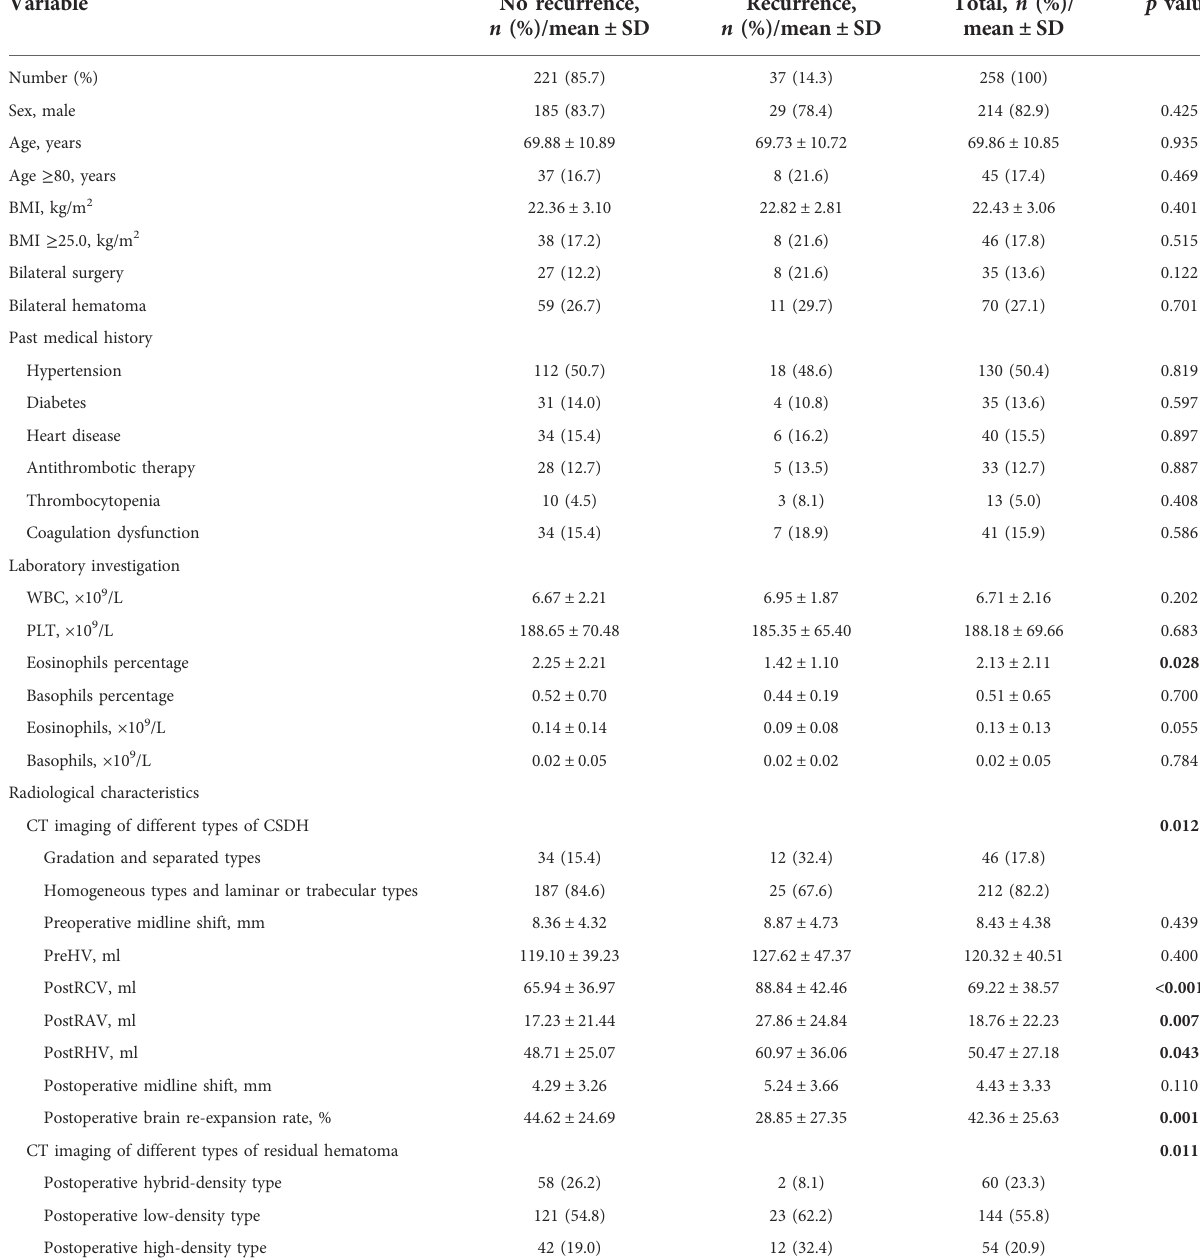
TABLE 1 Characteristics of patients with CSDH included in the study.